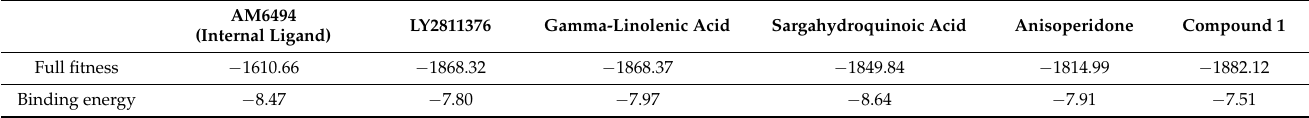
Figure 5. Binding modes of the allostery inhibitors on BACE1 through docking. LY2811376 converges mainly at the active site and partially on top of the flap and gamma-linolenic acid binds favorably at the primary site and two other secondary sites as predicted previously [31]. Sargahydroquinoic acid and anisoperidone interact at the active site and extend to the flap tip, while compound 1 binds at several regions. Table 1. Full fitness and binding energy (in kcal/mol) predicted from docking of potent allostery molecules to BACE1 active site. The co-crystalized ligand (AM6494) of 6PZ4 binds preferentially at the catalytic active site of BACE1 as proposed [42] and validates the accuracy of the docking method.